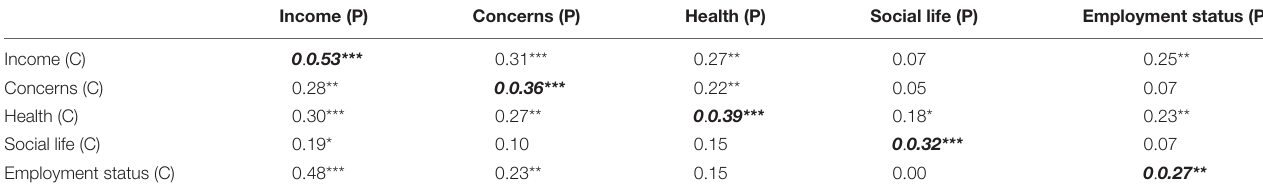
TABLE 3 | Correlation